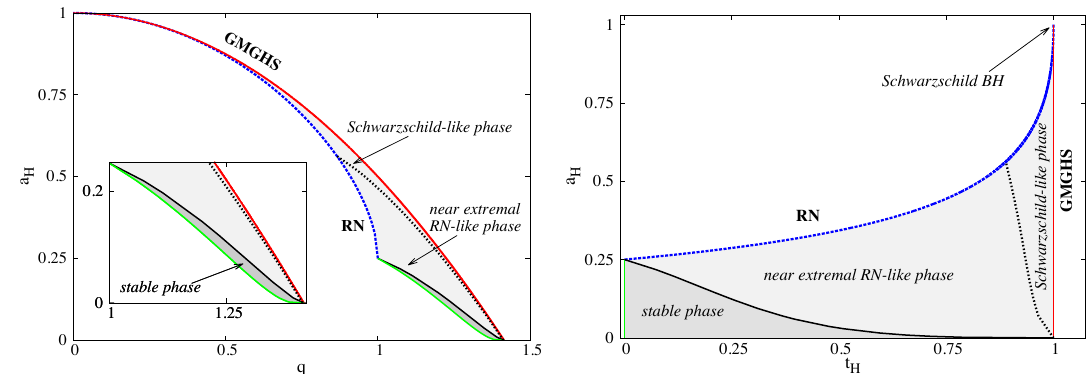
Figure 8 . The three thermodynamic phases of AAM BHs plotted in the same representations of the domain of existence shown in (cid:12)gure